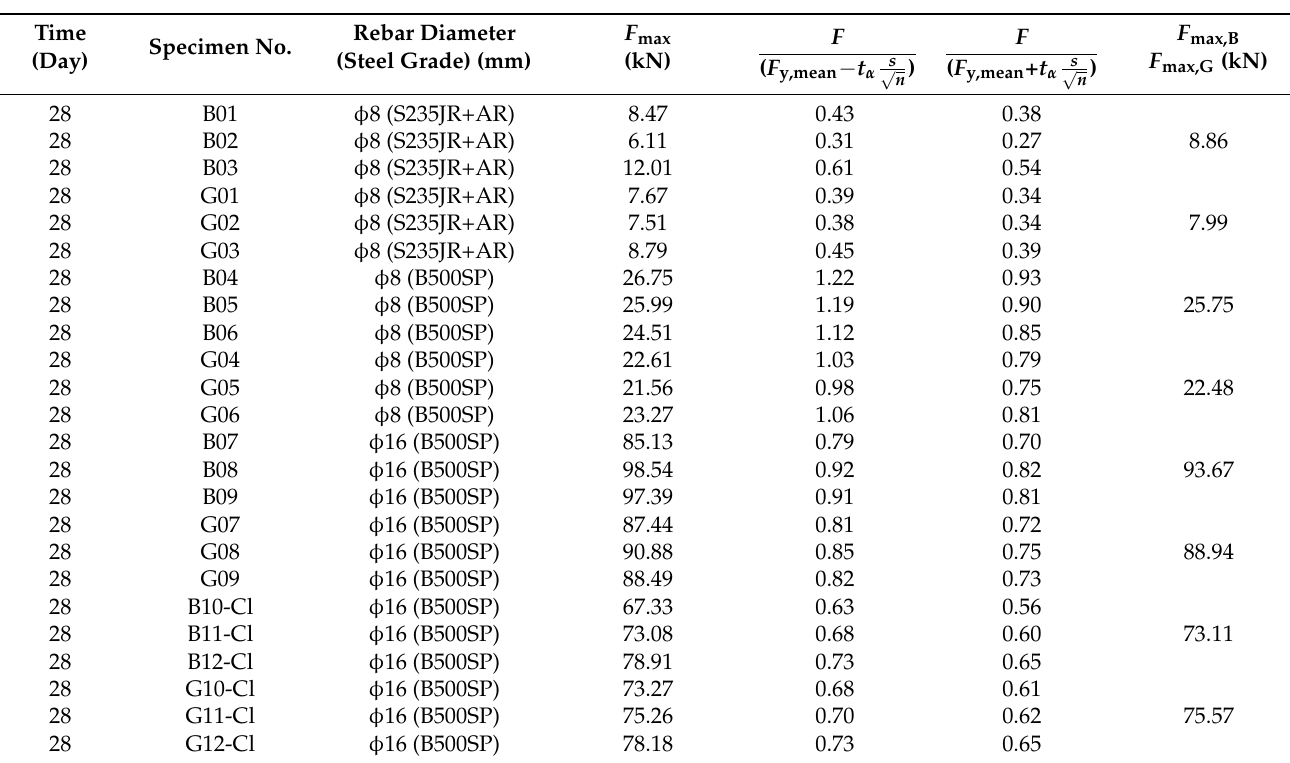
Table A3. The values of the pull-out force F acting on galvanized and black steel rebars in concrete with and without chlorides on day 28, 180, and 540 from the day of their setting in concrete. F y,mean —the force corresponding to yield strength of steel f y averaged from six values. n —number of the specimens ( n = 6), t α —variable with the t-student distribution for n − 1 degrees of freedom, s —the value estimating the standard deviation for samples according to the relationship (2), F B and F G —the value of the pull-out force acting on galvanized and black steel rebars averaged from three measurements. Time Specimen (Day)